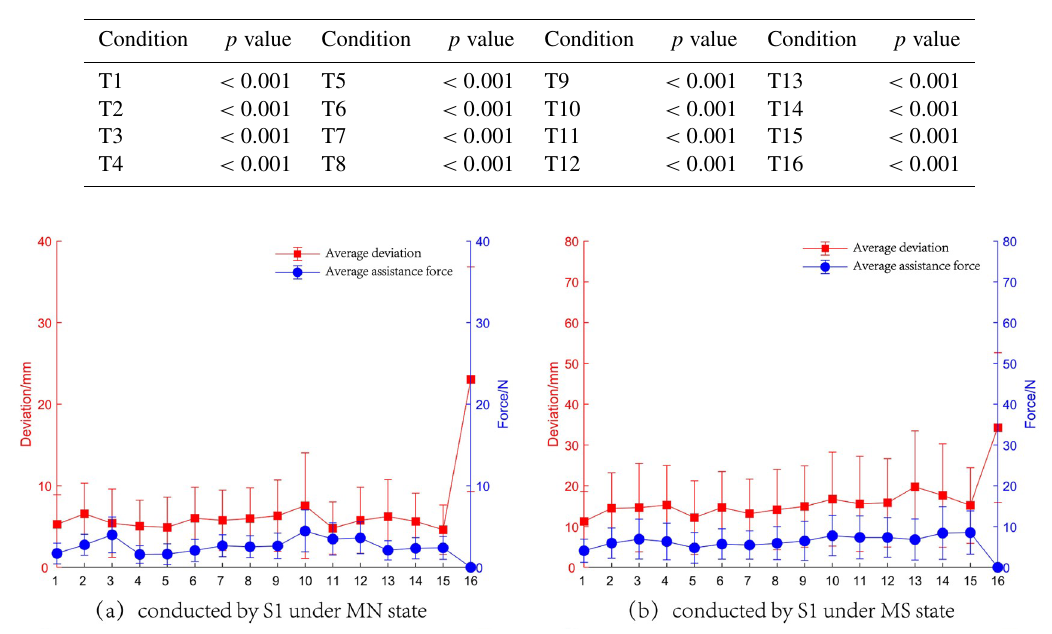
Table 3. Paired t test results between the MN state and the MS state in each condition.